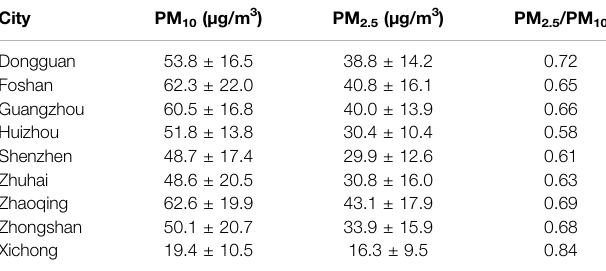
TABLE 1 | Mean PM mass concentration values observed in PRD during Dec. 2013 to Jun.